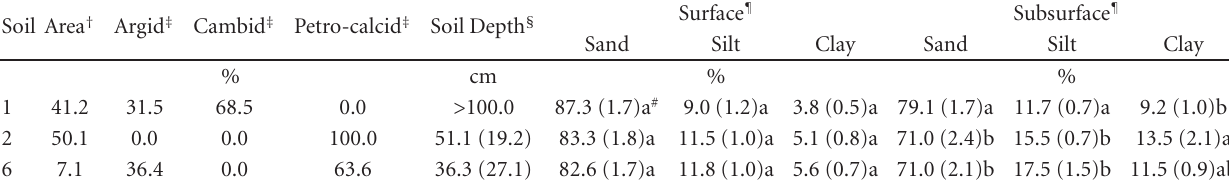
Table 4: Field attributes associated with mapped soil classes that include percent of study area for each soil class, distribution of soil taxonomic orders and suborders (where possible) within each soil class, and average soil class properties. Soil classes were mapped by supervised classification of Landsat ETM+ imagery and topographic indices. Data were derived from field surveys of 24 sites ( n = 8 for each soil class) where soils were augered to depth of 1